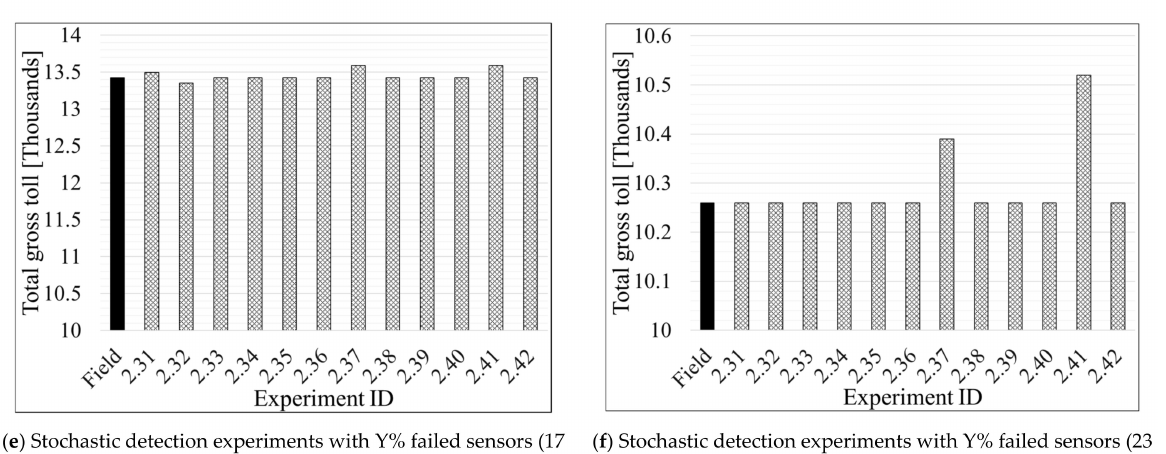
Figure 8. Graphical interpretation of total gross toll for systematic and stochastic failure and error scenarios on Northbound